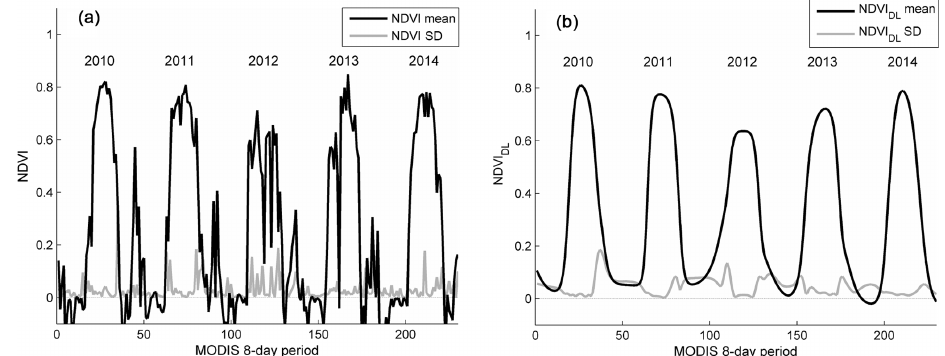
Figure 3. Mean (black) and standard deviation (grey) of NDVI 2010–2014 for the four pixels around the eddy covariance (EC) tower. Panel (a) is raw NDVI and (b) is NDVI fitted with double logistic functions in TIMESAT (NDVI DL ) . Years 2012 and 2013 are those with insect outbreak. In 2013 the birch forest was refoliating later in the growing season. There is small secondary peak in raw NDVI (a) appearing each year. This peak appears during the winter, when there is no vegetation in the study area, and is hence removed from the smoothed data (b)